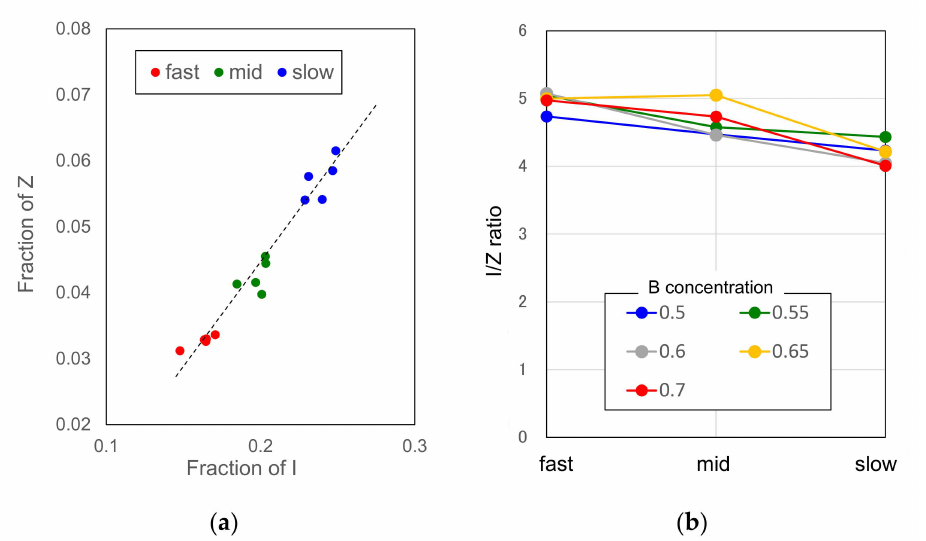
Figure 16. ( a ) The correlation between the populations of I- and Z-clusters for fifteen r BB = 0.8 A 1 − x B x glassy phases formed by different cooling rates for x = 0.5–0.7. ( b ) The cooling rate dependence of the I/Z ratio of the r BB = 0.8 A 1 − x B x glassy phases for x =